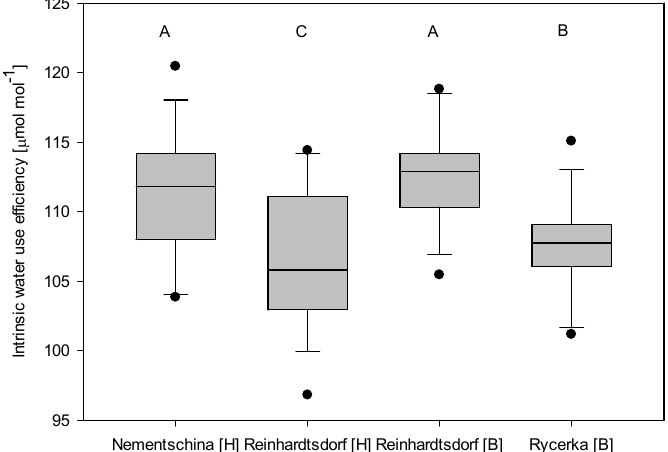
Figure 3. Mean intrinsic water use efficiency of the respective provenances and sites (H = Hohenleipisch; B = Borstendorf); Different letters indicate statistically significant (Bonferroni t -test, p < 0.05) differences.